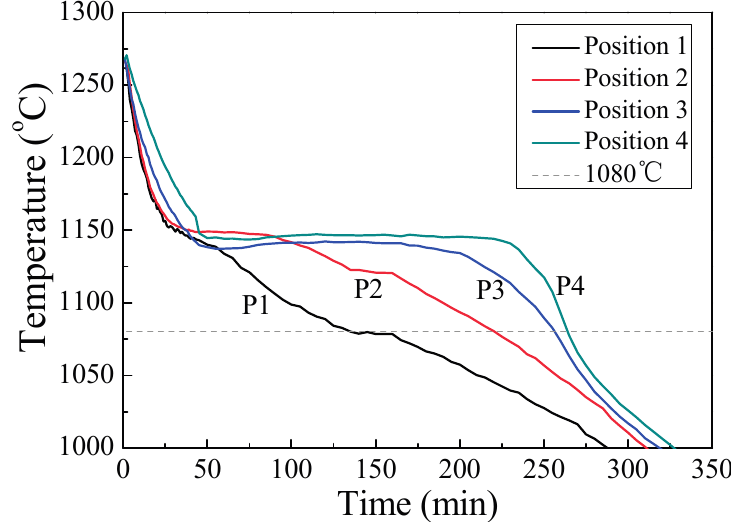
Figure 3. Dimensions of the in situ SEM tensile specimen.